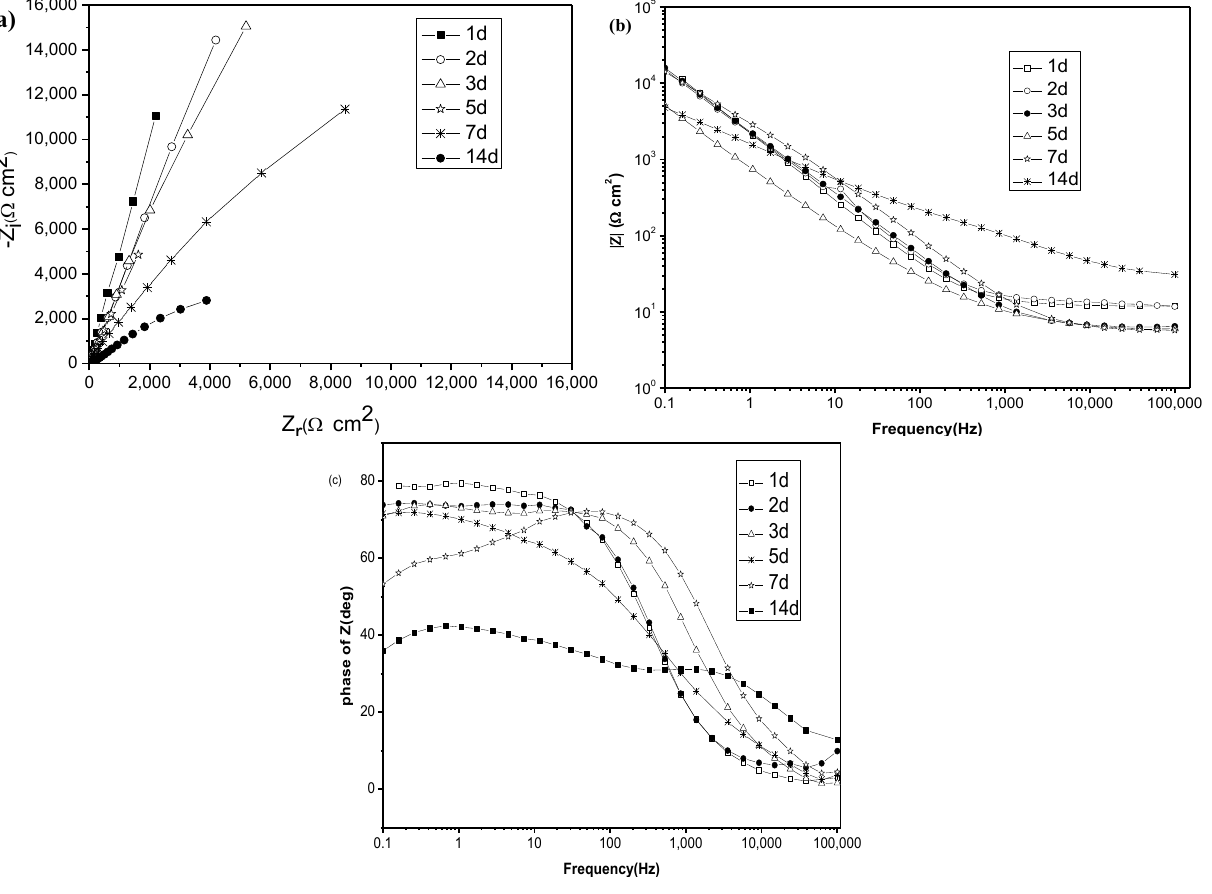
Figure 3. EIS of titanium immersed for different times in artificial saliva without lactic acid. ( a ) Nyquist plots; ( b ) bode modulus diagrams; and ( c ) bode phase angle diagrams.